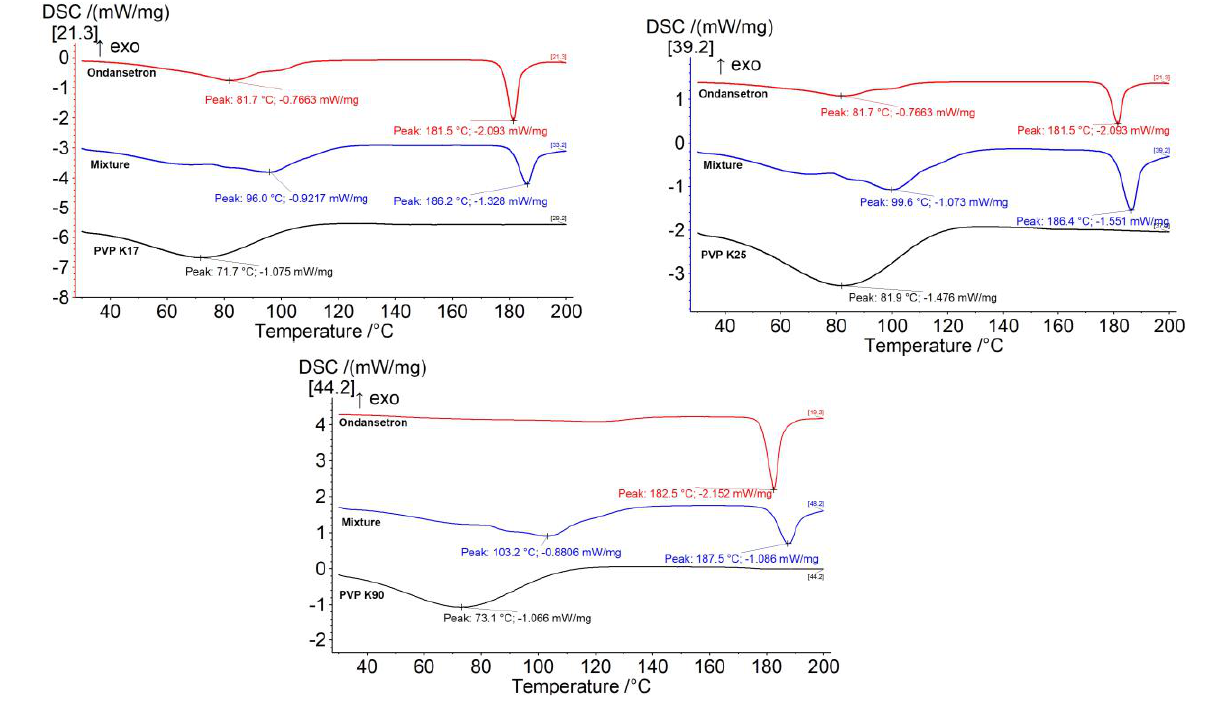
Figure 5. DSC thermograms of single materials and physical mixtures between ondansetron and PVPs (K17, K25 and K90).